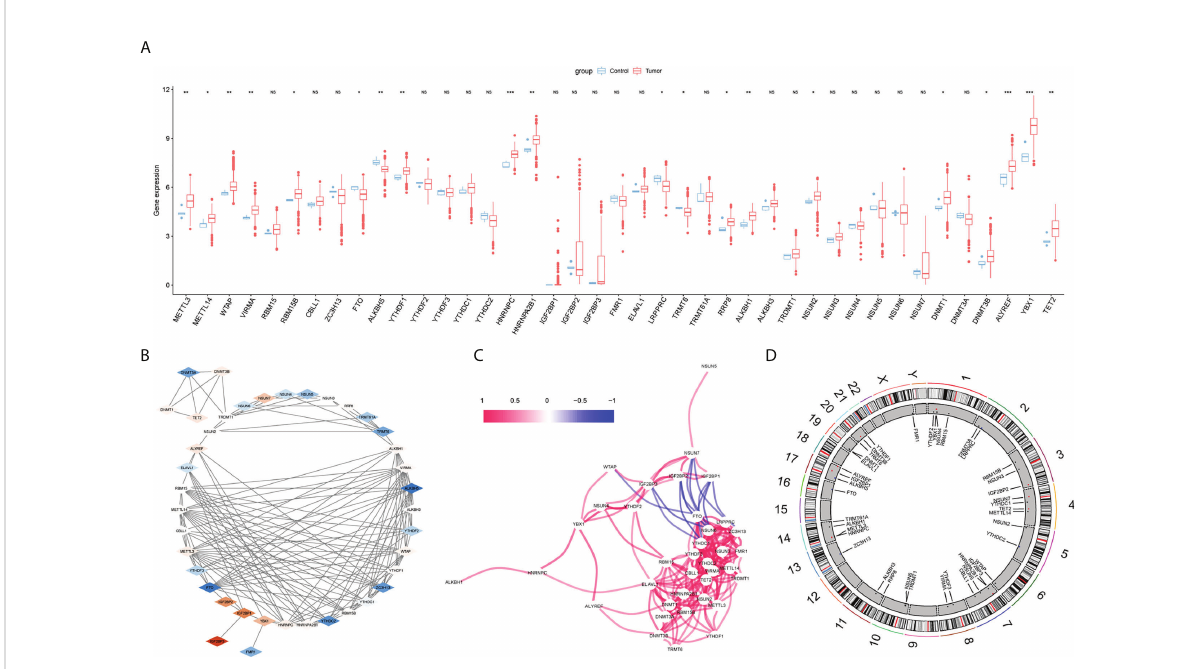
FIGURE 2 m 6 A/m 5 C/m 1 A related genes analysis. (A) The difference expression of m 6 A/m 5 C/m 1 A related genes between glioma and control samples, with red representing tumor group and blue representing normal group. (B) Protein-protein interaction diagram, different colors represent log2FC values (obtained by comparing normal group and tumor group with Deseq2 package), orange represents log2FC >0, blue represents log2FC < 0, and the darker the color, the larger |log2FC|. (C) Correlation network diagram, red line represents positive correlation and blue represents negative correlation; chromosome map shows the distribution of genes related to m 6 A/m 5 C/m 1 A on chromosomes (D) . (NS:no signi fi cant) (*P < 0.05, **P < 0.01, ***P <